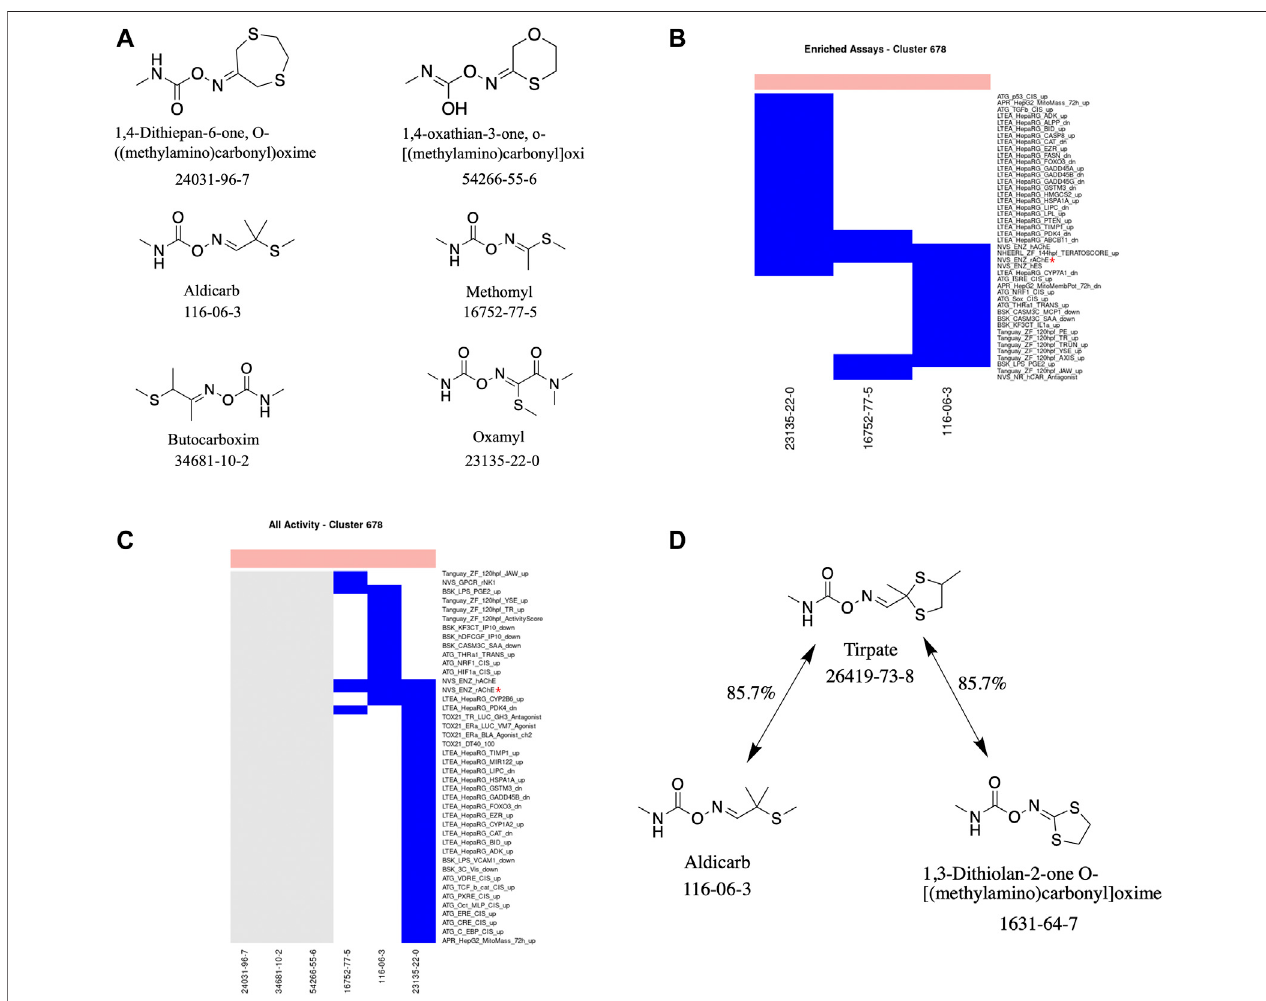
FIGURE4 | Cluster 678 structure and activity information. (A) Structuresfor chemicals incluster678. (B) Heatmapshowing activity belowthe cytotoxicity range in the assaysthat wereenriched forthis cluster. Only chemicals withactivity inat least oneassay areshown. (C) Heatmap showingactivity forall assayswhere at least one chemicalfromtheclusterwasactive.Notallassaynamesareshown. (D) Structureoftirpatecomparedwithchemicalsfromclusters390and678.Heatmapcolors:blue = active below cytotoxicity, light blue = active above cytotoxicity, white = inactive, grey = not tested. Top of heatmap: red = toxic, blue = nontoxic. Red asterisks identify the assay(s) selected for that